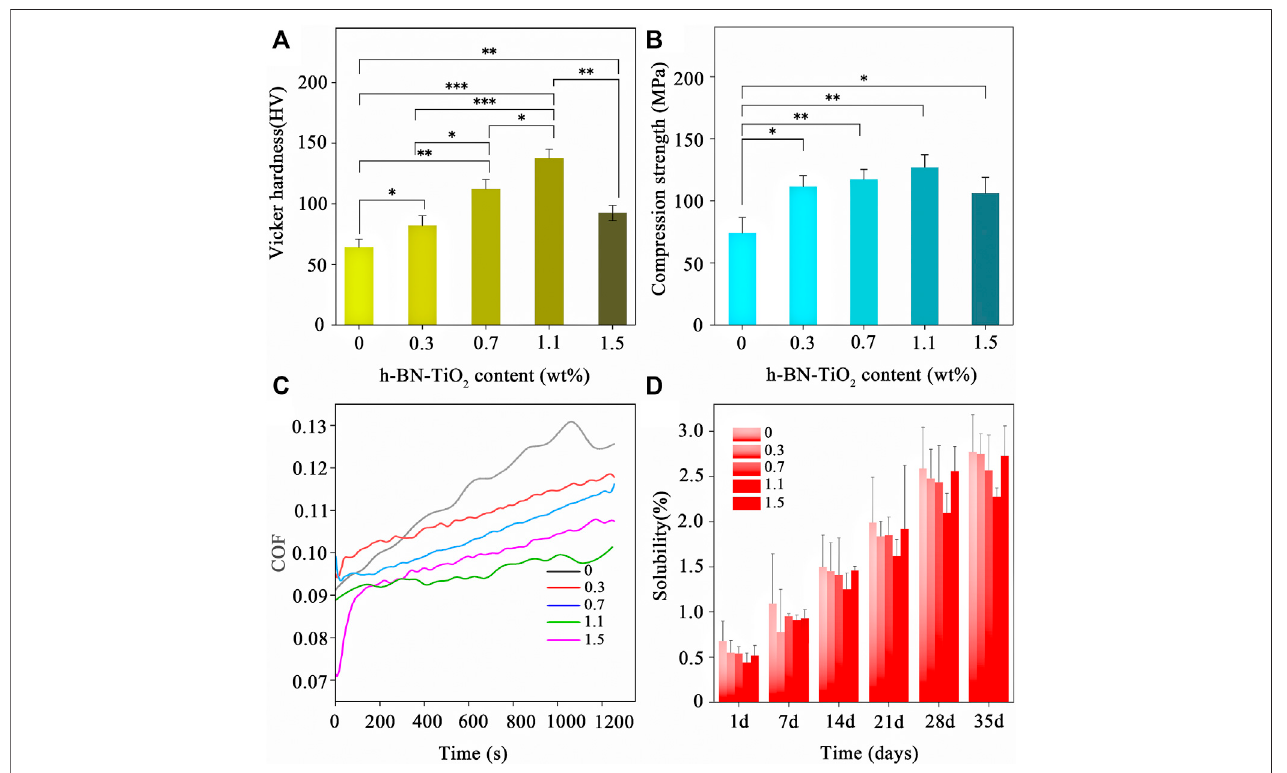
FIGURE 4 | Mechanical properties and solubility of h-BN-TiO 2 /GIC composite (0, 0.3, 0.7, 1.1, 1.5 wt%). (A) Vicker hardness (in HV); (B) Compression stress (in MPa); (C) the real-time COF; and (D) solubility (%).